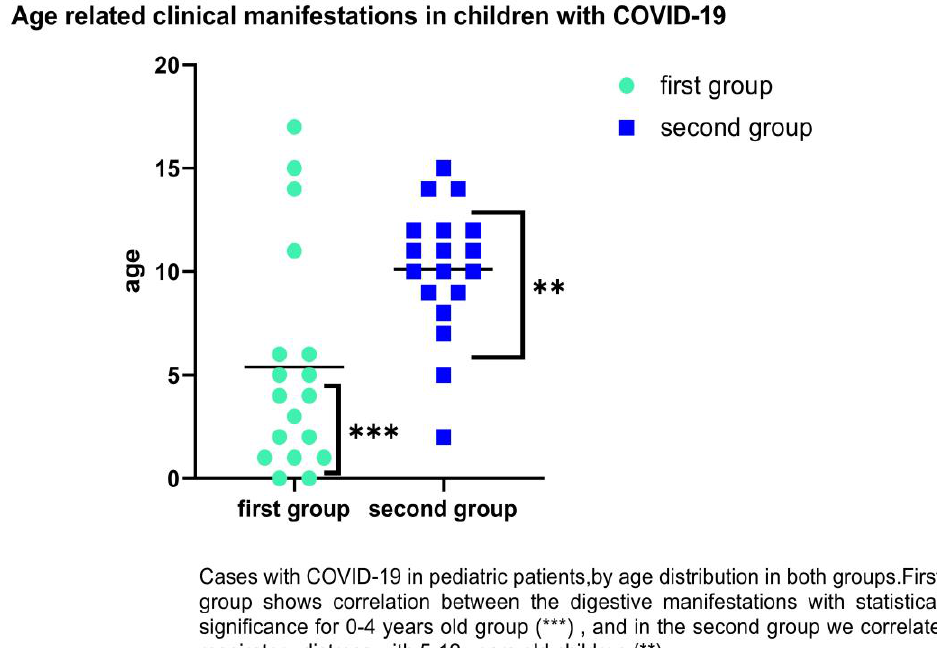
Figure 4. Distribution of COVID-19 cases in children by age and clinical symptoms (respiratory and digestive). Statistically significance **— p ≤ 0.01, ***— p ≤ 0.001 .